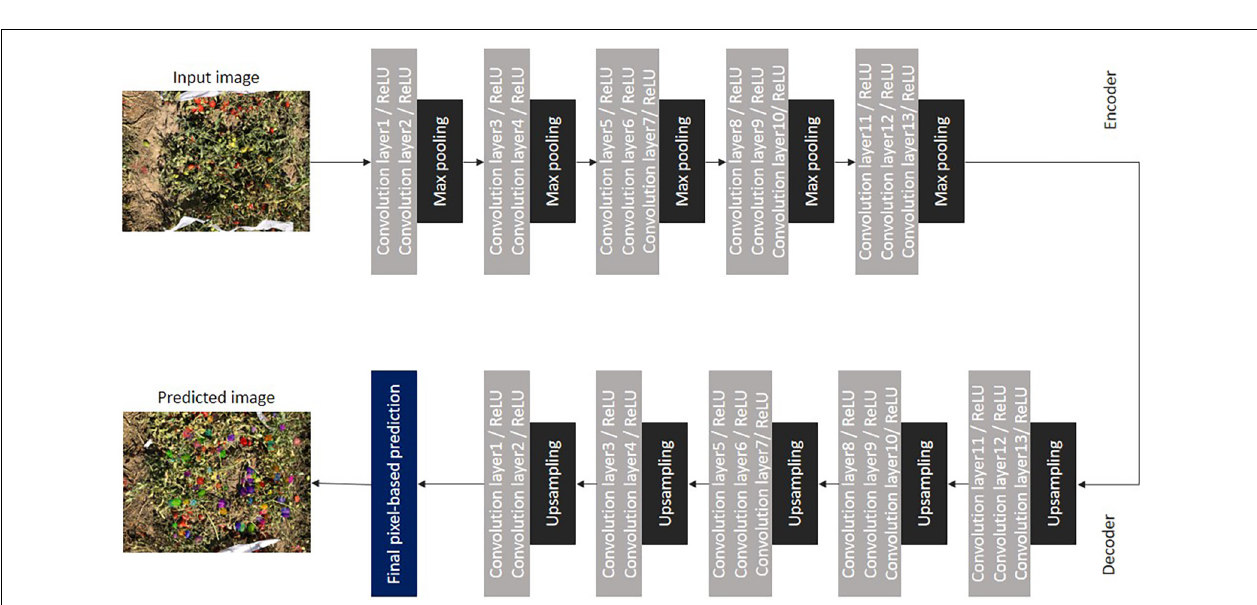
FIGURE 7 | Encoder-decoder architecture of